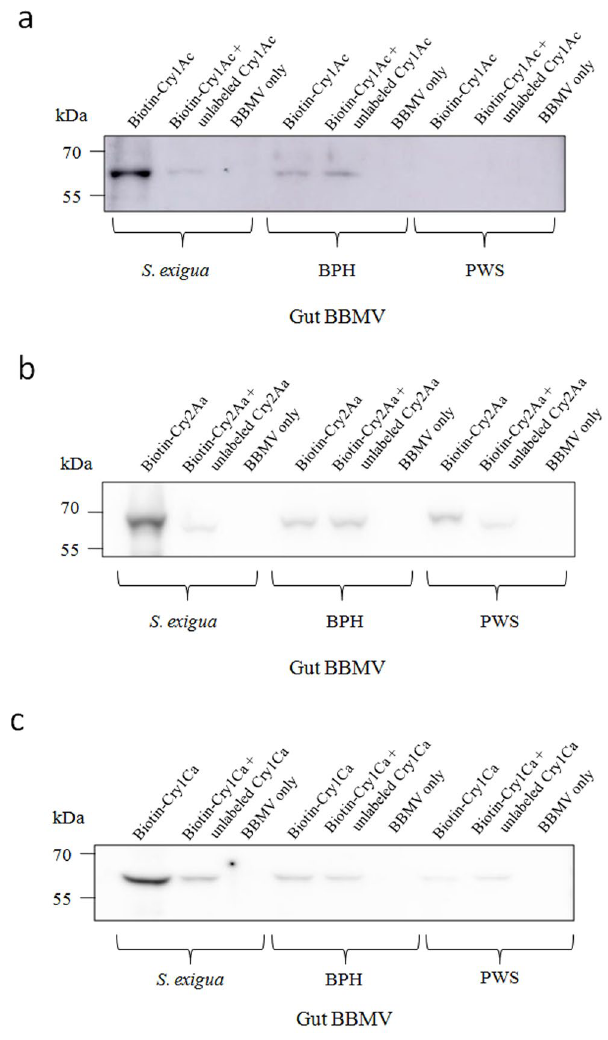
Figure 1. Binding of biotinylated Cry1Ac ( a ), Cry2Aa ( b ) and Cry1Ca ( c ) to BPH and PWS gut BBMV. Twenty micrograms of BBMV protein were used along with 0.1 micrograms of biotinylated Cry proteins. A 100-fold excess of unlabeled Cry1Ac, Cry2Aa or Cry1Ca was used in competition assays. Toxin binding to S . exigua gut BBMV was used as a positive control